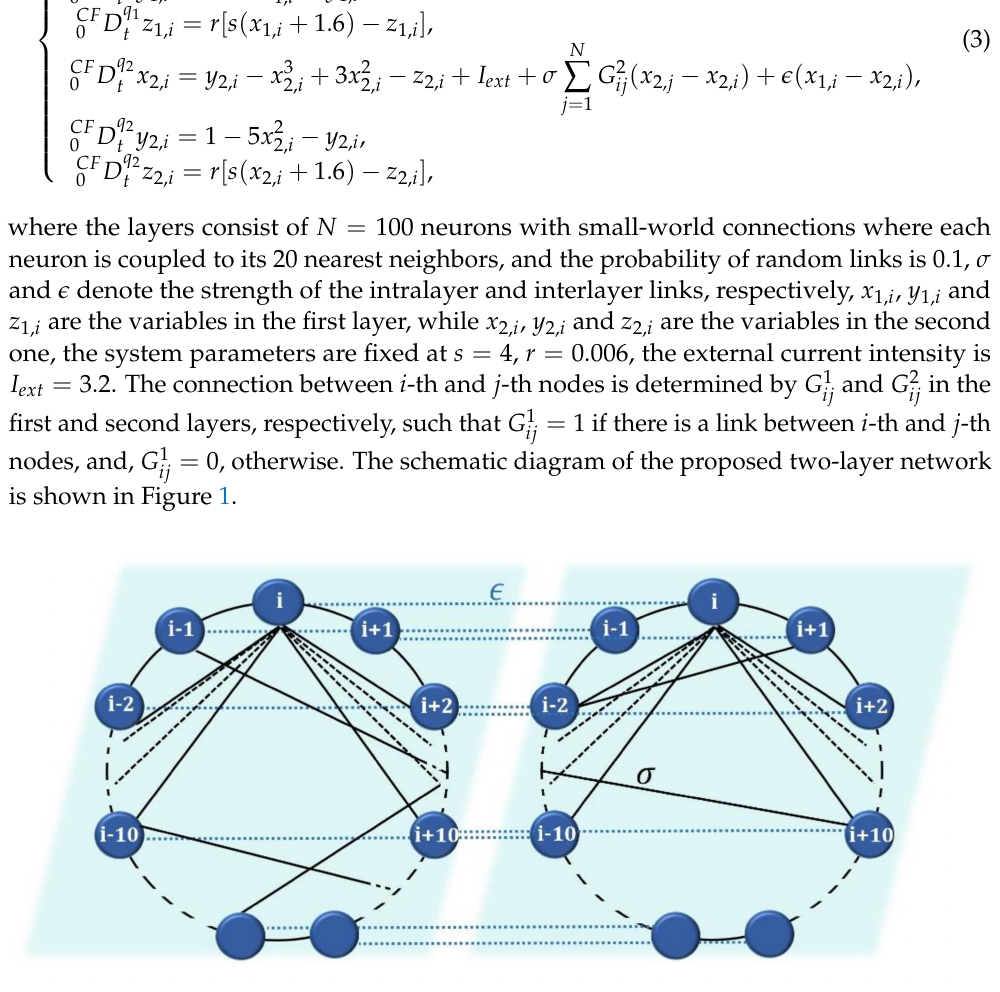
Figure 1. The schematic diagram of the two-layer network (3). Each layer is a small-work network with 20 nearest neighbors connections and additional random links. The coupling strength within and between the layers is σ and (cid:101) ,